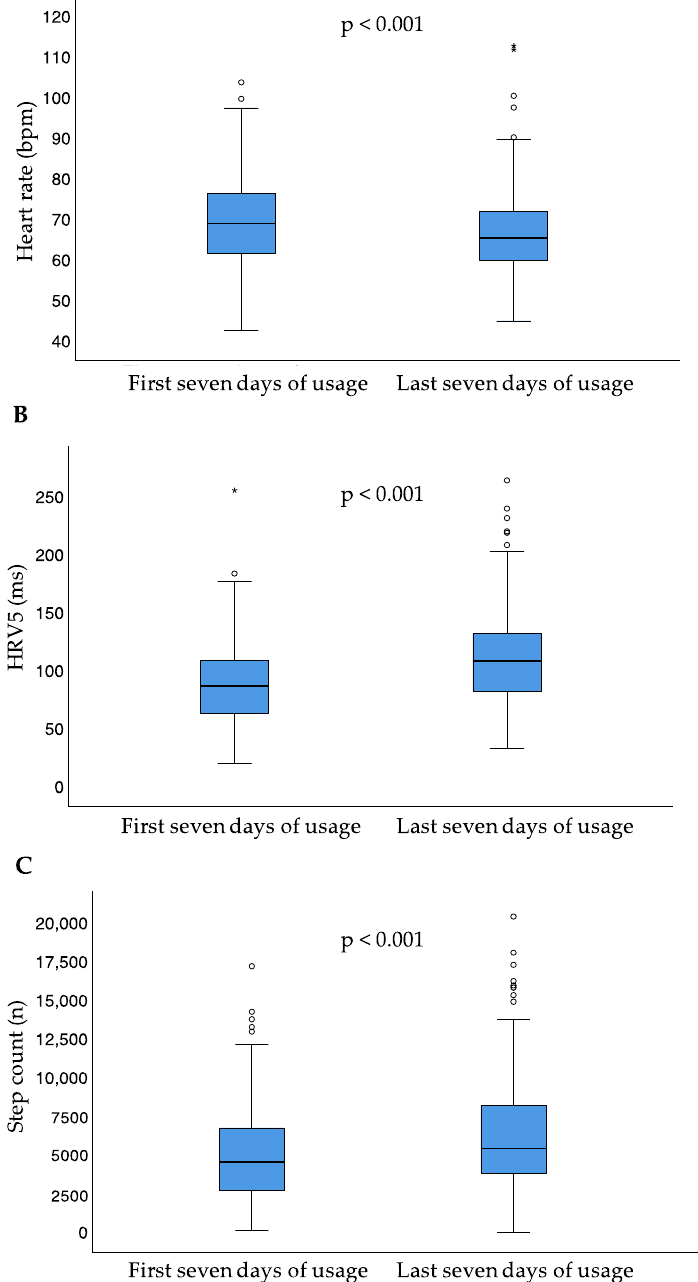
Figure 4. Heart rate ( A ), heart rate variability approximate ( B ), and step count ( C ) for the first and last seven days of usage; small circles represent outliers (data points outside the range of 3rd quartile + 1.5* interquartile range or 1st quartile − 1.5* interquartile range); aster- isk represent extreme outliers (data points outside the range of 3rd quartile + 3* interquar- tile range or 1st quartile − 3* interquartile range); bpm = beats per minute; HRV5 = heart rate variability